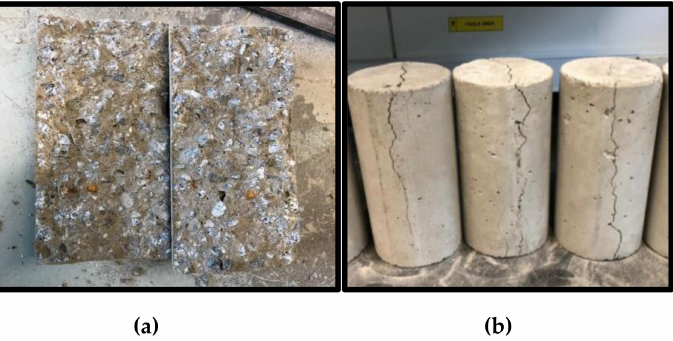
Figure 14. Splitting tensile test samples at failure: ( a ) control and ( b ) HVFA–CRC samples. The behavior of the HVFA–CRC due to the effect of the CR and FA replacement values is shown visually using the 2D contour and 3D response surface plots in Figure 15a,b, respectively. The graphs depict how the interaction of the independent variables affected the response (TS).